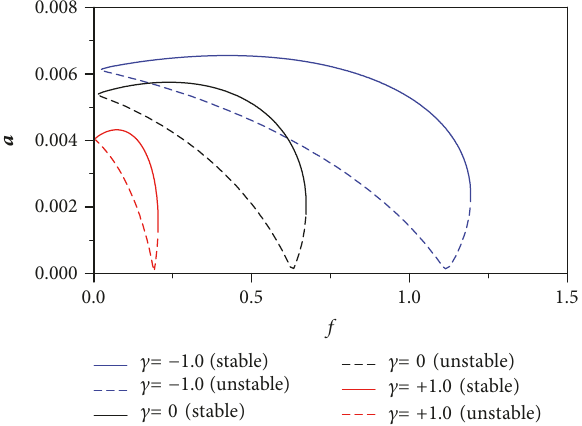
Figure 6: Excitation response curves of subharmonic resonances in the case of hinged-hinged boundary condition (𝜎 = 2.0)